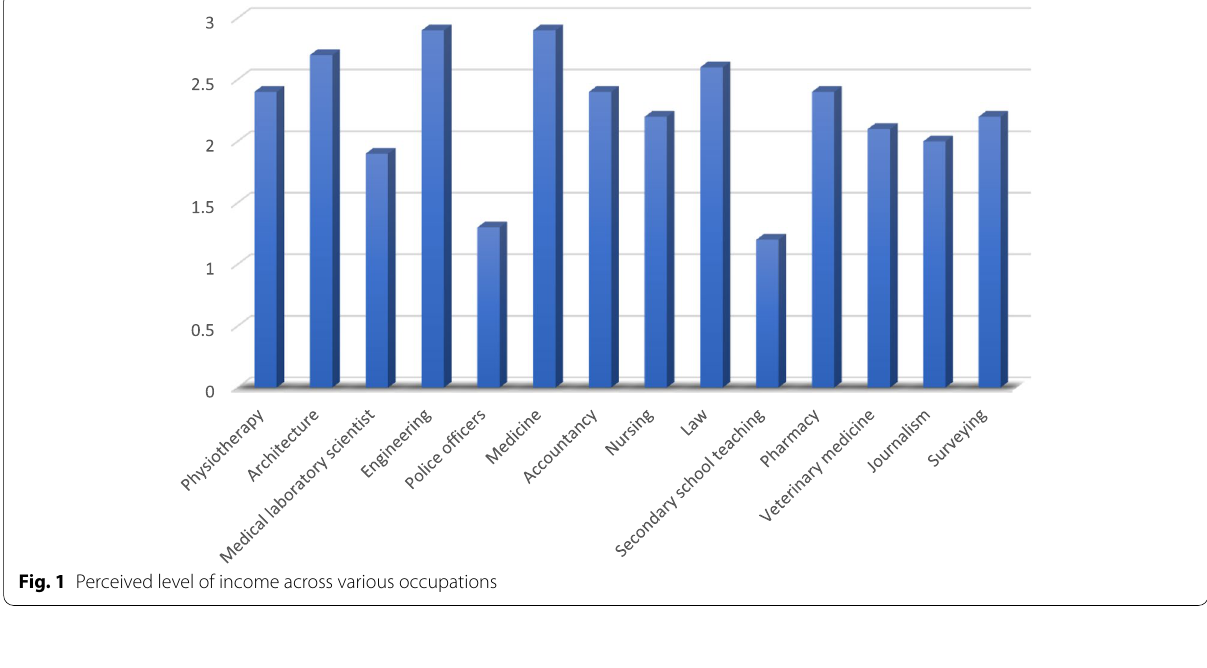
Fig. 1 Perceived level of income across various occupations